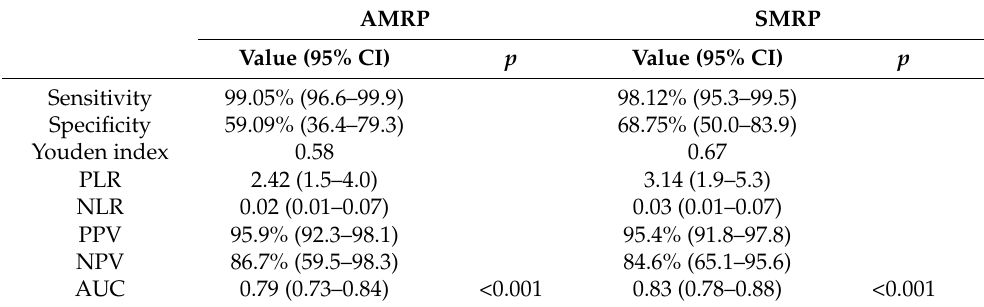
Table 2. Diagnostic properties of the abbreviated MRI (AMRP) and standard MRI (SMRP) protocols. AMRP SMRP Value (95% CI) p Value (95% CI) p Sensitivity 99.05% (96.6–99.9) 98.12% (95.3–99.5) Specificity 59.09% (36.4–79.3) 68.75% (50.0–83.9) Youden index